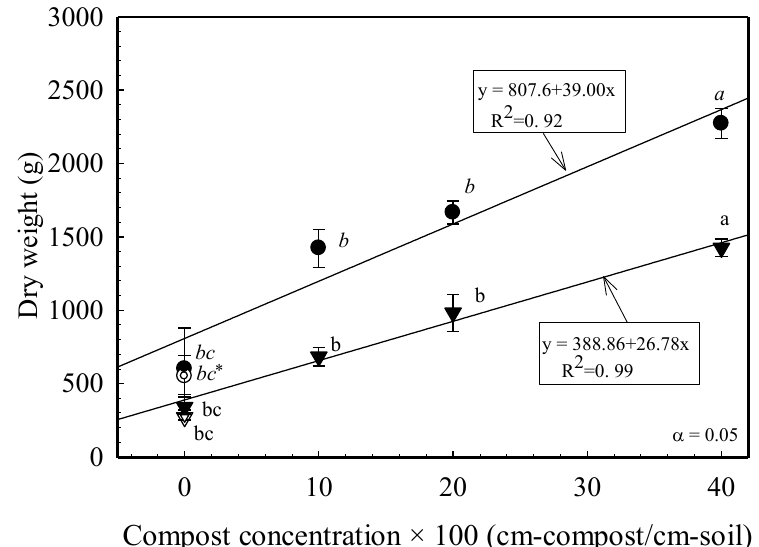
Figure 1. Effect of incorporating composted poultry litter into top 12.7 cm of subsoil on Kentucky bluegrass clipping dry weight for ● sodded compost; ○ sodded fertilizer; ▼ seeded compost; and seeded fertilizer plots; * Means with same letters are statistically insignificant based on Fisher’s Protected LSD test ( P ≤ 0.05) (italicized statistics correspond to sodded